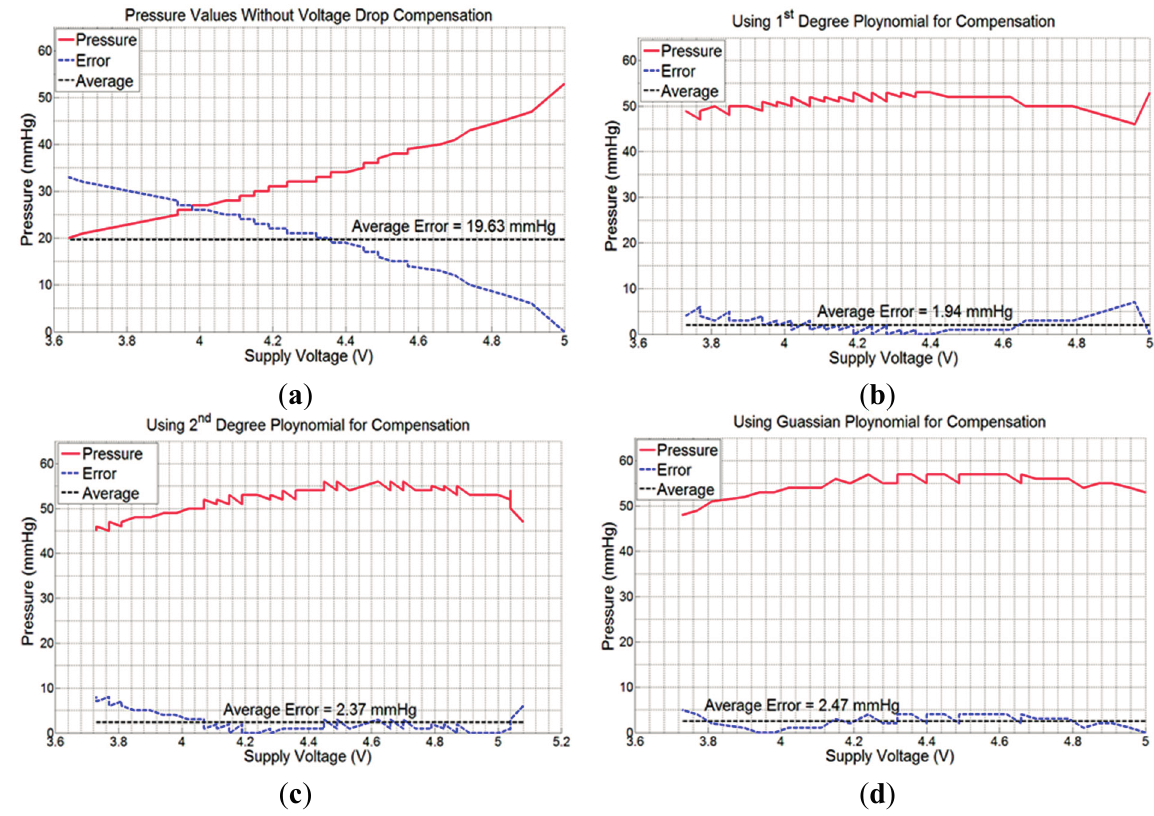
Figure 7. Graphical plots of measured pressure, error, and average error; ( a ) without using any compensation algorithm; ( b ) using 1st degree polynomial in Equation (3); ( c ) using 2nd degree polynomial in Equation (4); ( d ) using Gaussian exponential function in Equation